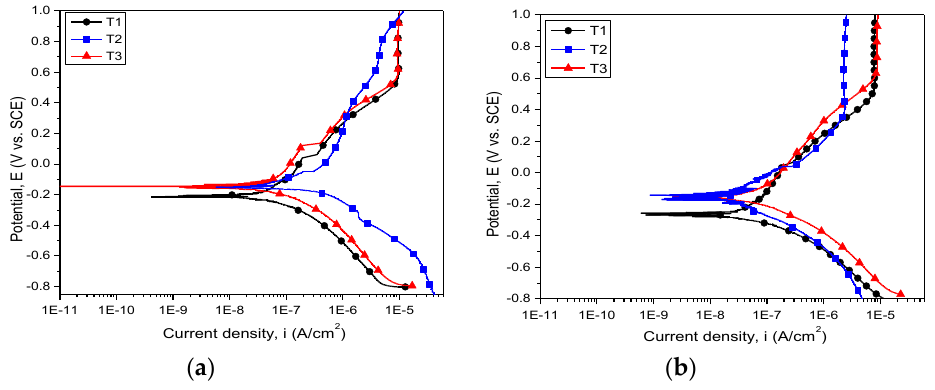
Figure 7. Open circuit potential vs. time curves of the investigated alloys in ( a ) SBF and ( b ) Hank solution.